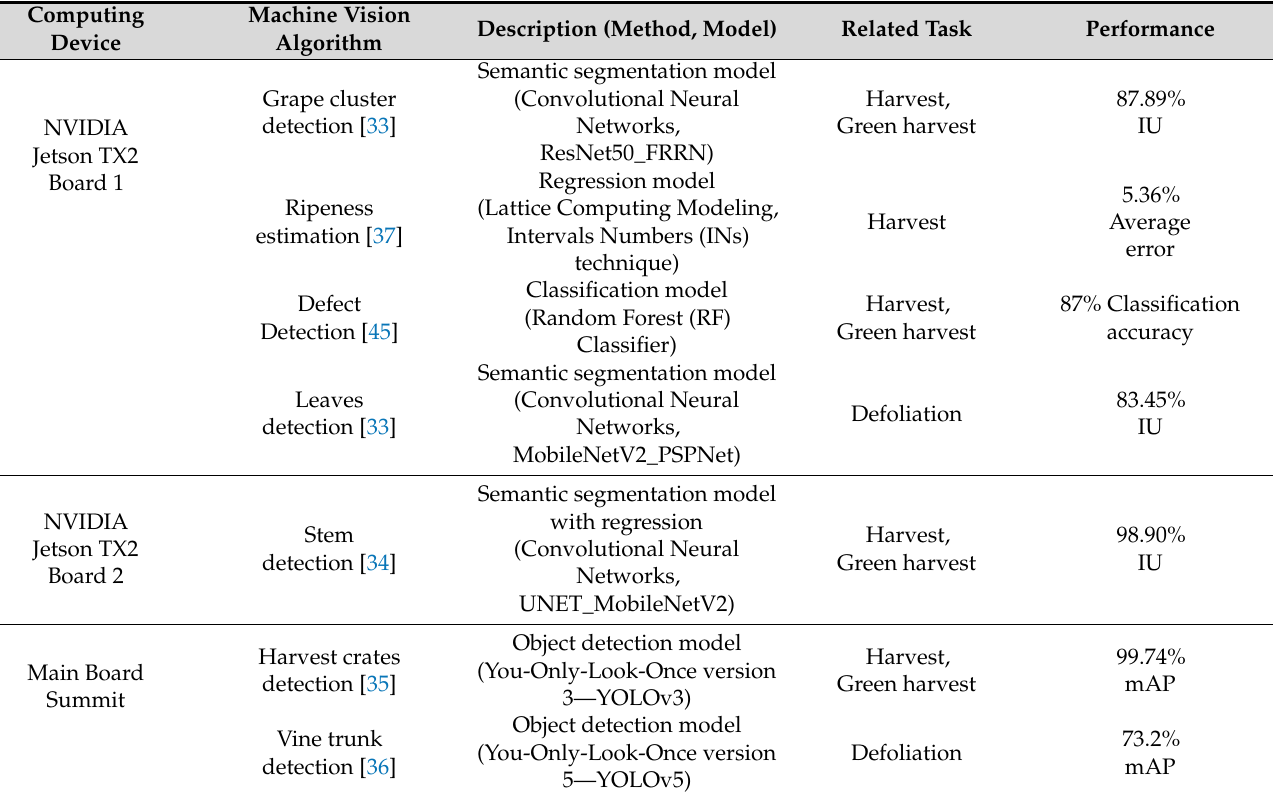
Table 3. Hardware computing devices and machine vision